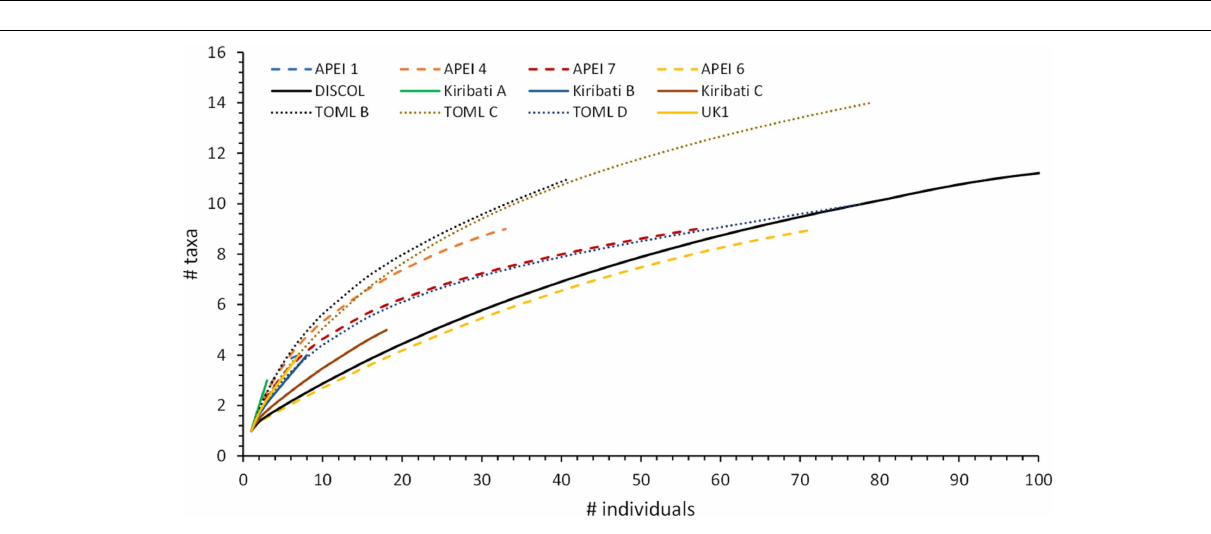
Frontiers in Marine Science |